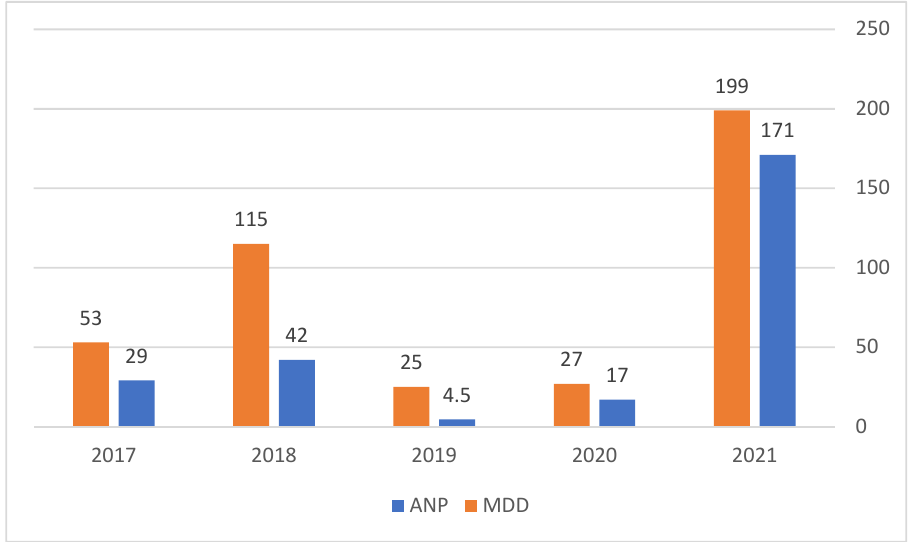
Figure 4. Ethereum average NP and MDD per trade for 2017–2021. Note: ANP = average trade net profit, MDD = maximum loss per trade. The data for 2021 is until the end of September 2021.